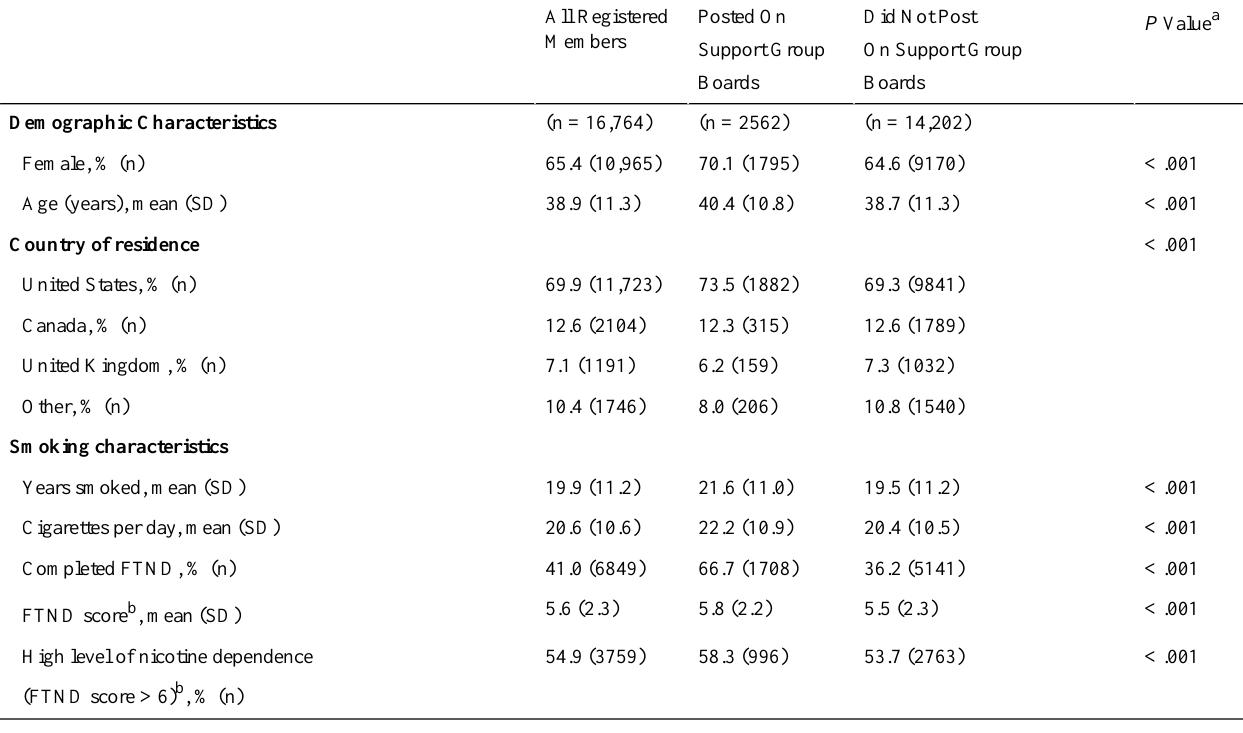
Table 1. Demographic and smoking characteristics of registered members of StopSmokingCenter.net version 5.0 (November 6, 2004, through